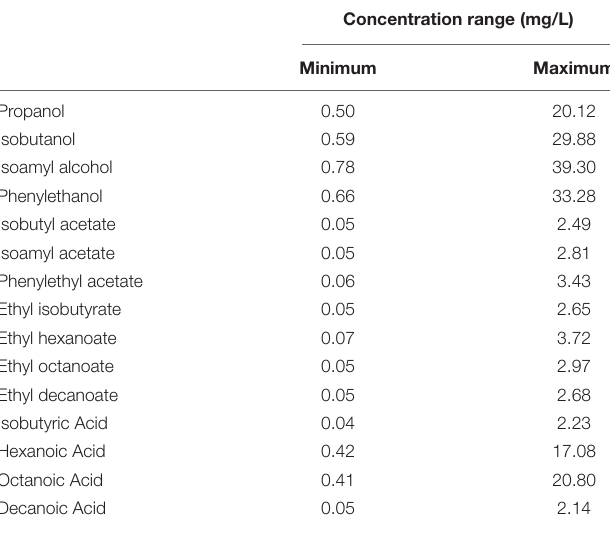
TABLE 3 | Concentration ranges (in mg/L) of volatile compounds measured by